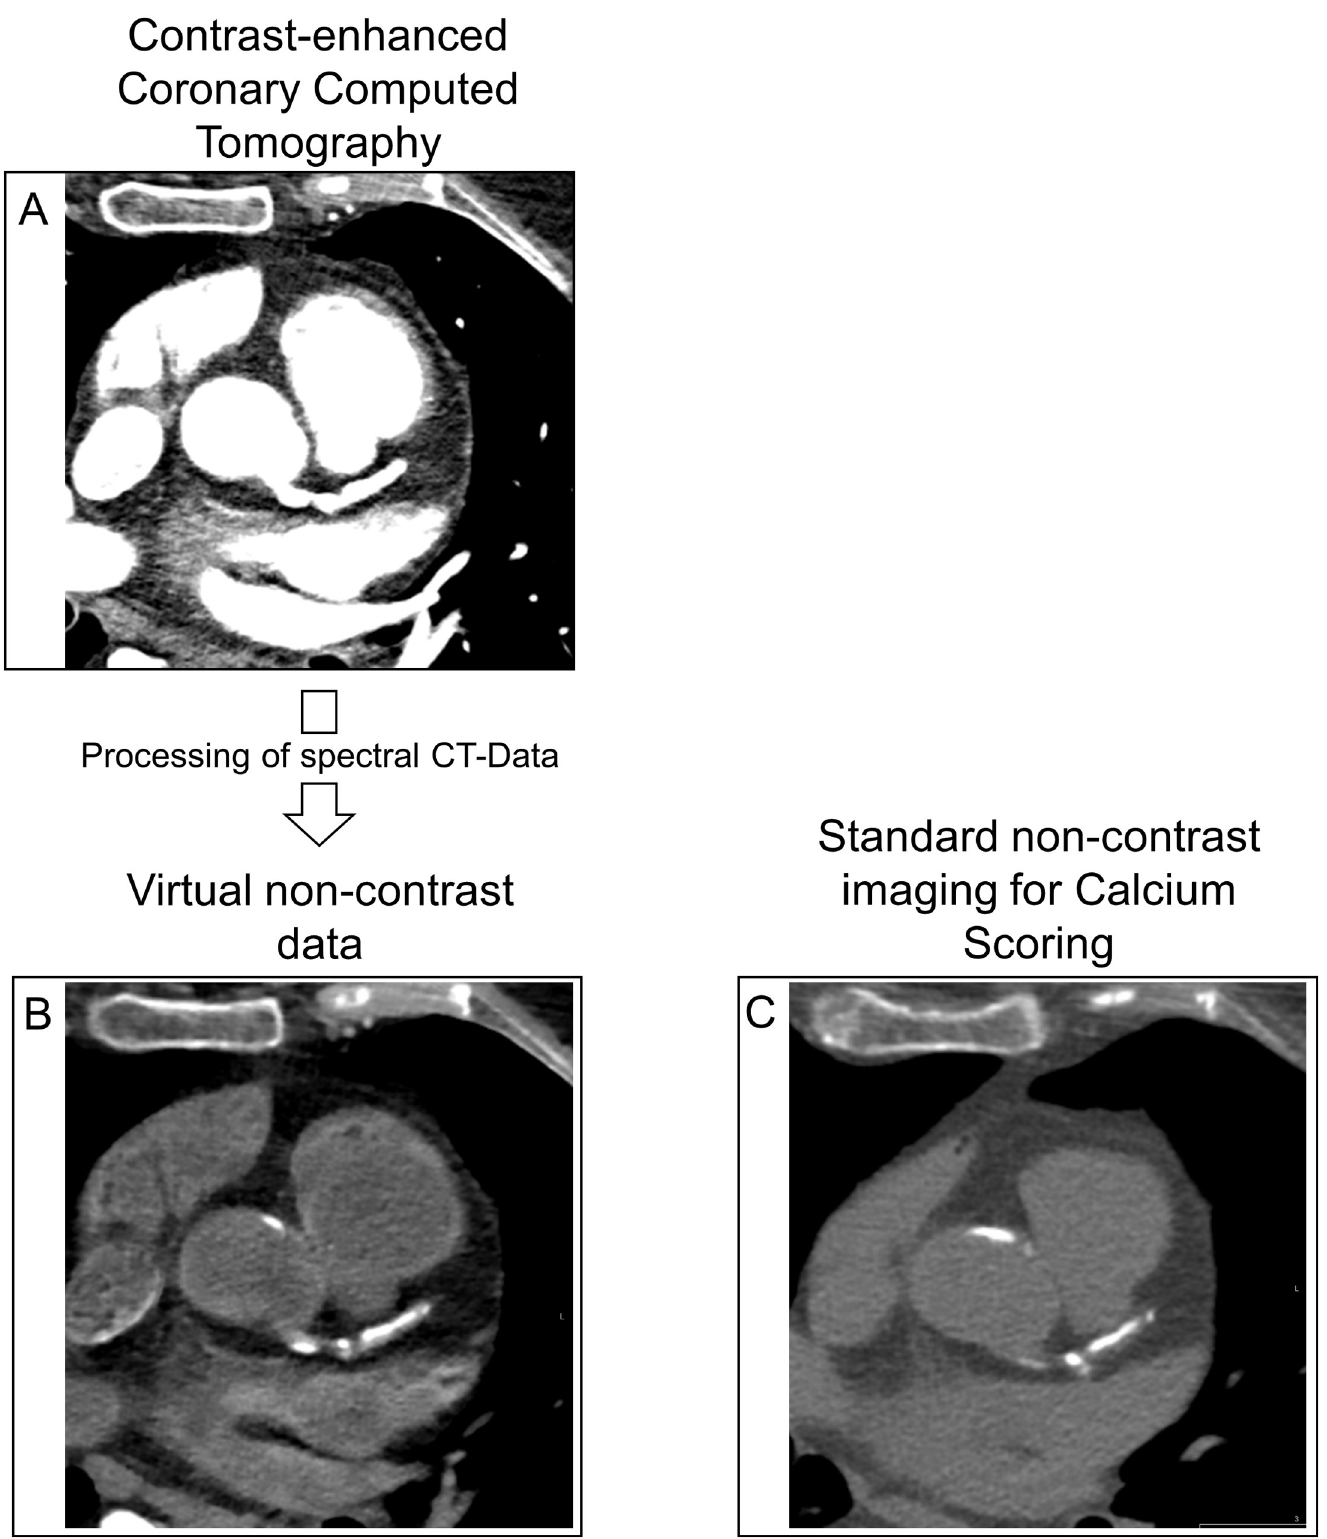
Fig 1. Calcium Scoring from Coronary Computed Tomography Angiography. A) Coronary Computed Tomography Angiography (CCTA) after administration of iodine contrast with the dual-layer detector allowing for spectral data acquisition. B) Example of a virtual non-contrast image calculated form spectral data set. C) Conventional non-contrast imaging for Calcium Scoring in the same patient and slice for